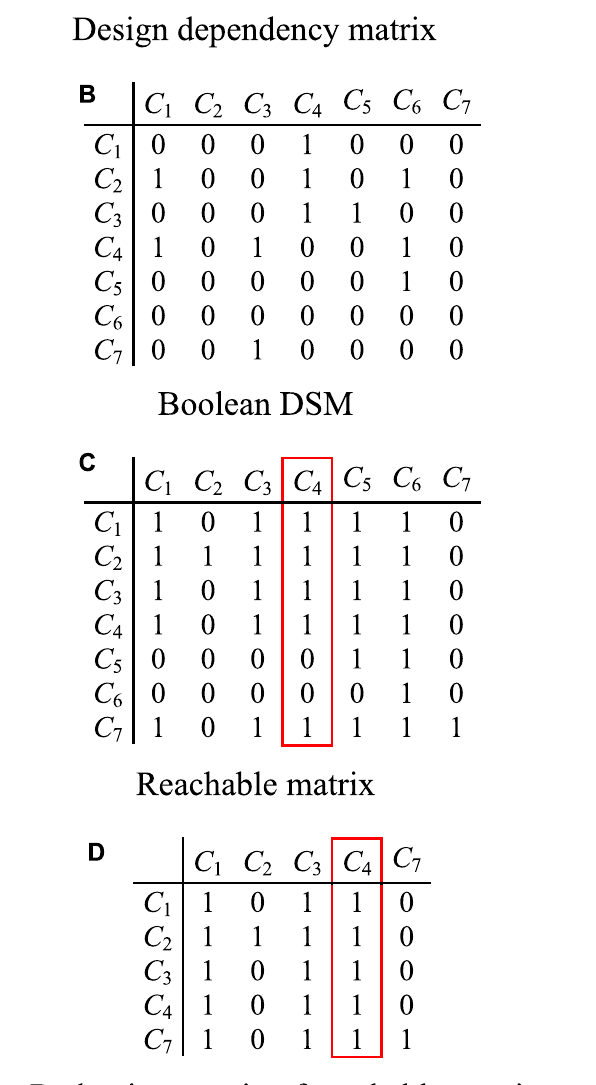
FIGURE 3 | Identifying reachable parts of change propagation using reachable